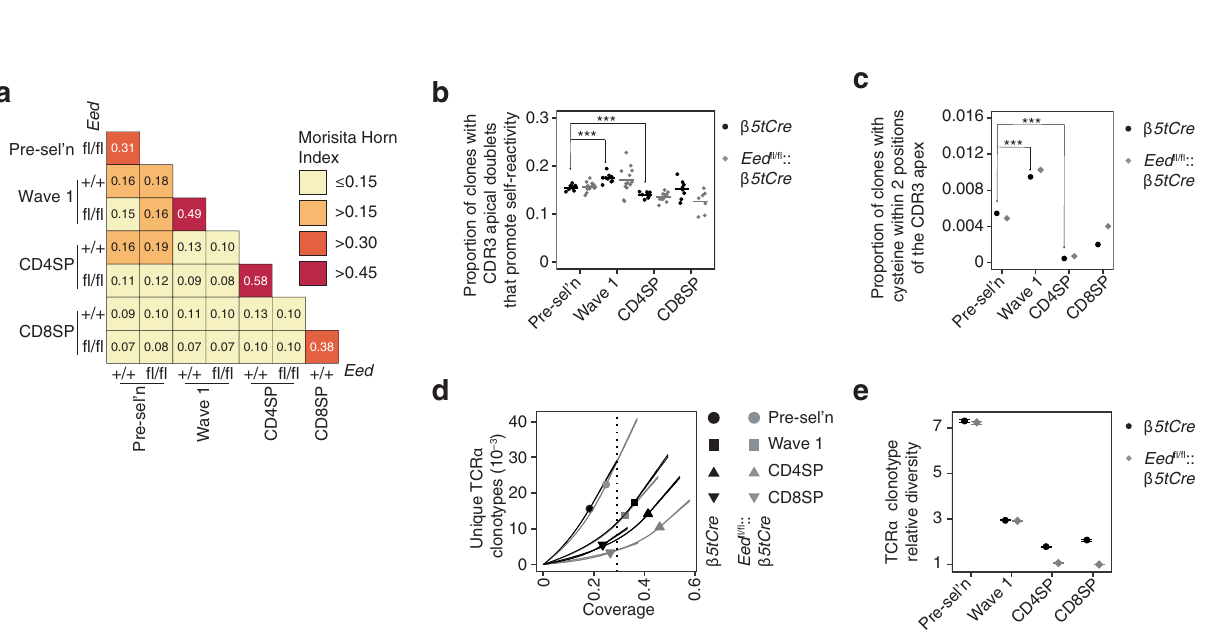
Fig. 4 Negative selection and TCR avidity are reduced in a EED-de fi cient thymic microenvironment. Analysis of negative selection of CD4 lineage thymocytes in the cortex ( a ) and the medulla ( b ). CD5 and TCR geometric mean fl uorescence intensity on indicated thymocyte subsets ( c ). Quanti fi cation of apoptotic cells in Helios-positive thymocyte subsets ( d ). Analysis of thymocyte development in Eed : fl /wt : β 5tCre and control mice. Frequencies of preDP, DP and SP subsets, developmental stages within preDP thymocytes, maturation within SP cells, frequencies of Treg in CD4SP and frequencies of negatively selected cells ( e ). Representative fl ow cytometry contour and histogram plots are shown. Bar graphs display mean values with SD together with individual data points from n = 6 Eed fl / fl and n = 9 Eed fl / fl :: β 5tCre mice at 3 weeks of age ( a – c ) or n = 3 Eed fl / fl and n = 3 Eed fl / fl : : β 5tCre mice at 4 weeks of age ( d ) representative of at least two independent experiments. Eed fl / fl :: β 5tCre : white bars with grey diamonds, Eed fl / fl grey bars with black circles. Data in ( e ) are pooled from two independent experiments with female ( n = 4 Eed fl /wt : : β 5tCre : light grey bars with grey diamonds, n = 4 Eed fl /wt black bars with grey circles) and male mice ( n = 6 Eed fl /wt : : β 5tCre : light grey bars with white diamonds, n = 2 Eed fl / fl black bars with white circles) at 4 – 6 weeks of age. n = biologically independent replicates per group. * p < 0.05, ** p < 0.01, *** p < 0.001 (two-tailed unpaired Student ’ s t test). The gating for thymocyte subsets is displayed in Supplementary Fig. 3. Source data including exact statistical test values are provided in the Source Data fi le.